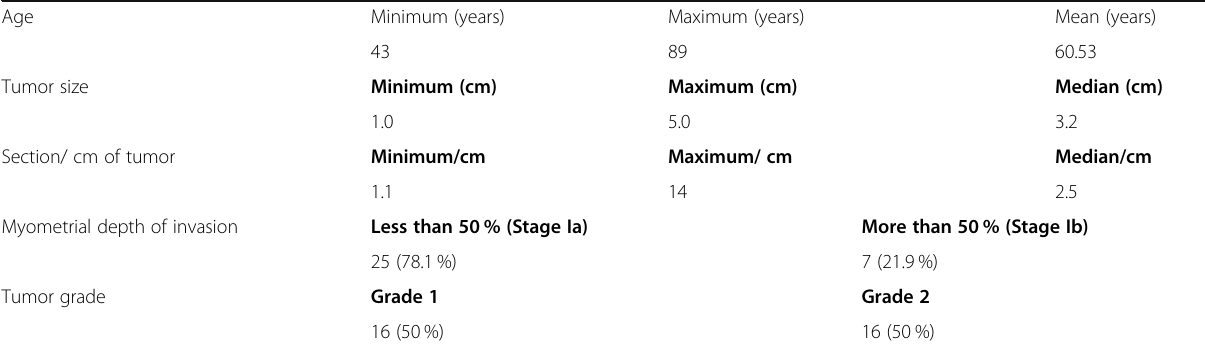
Table 1 Clinicopathologic characteristics of 32 cases included in the study